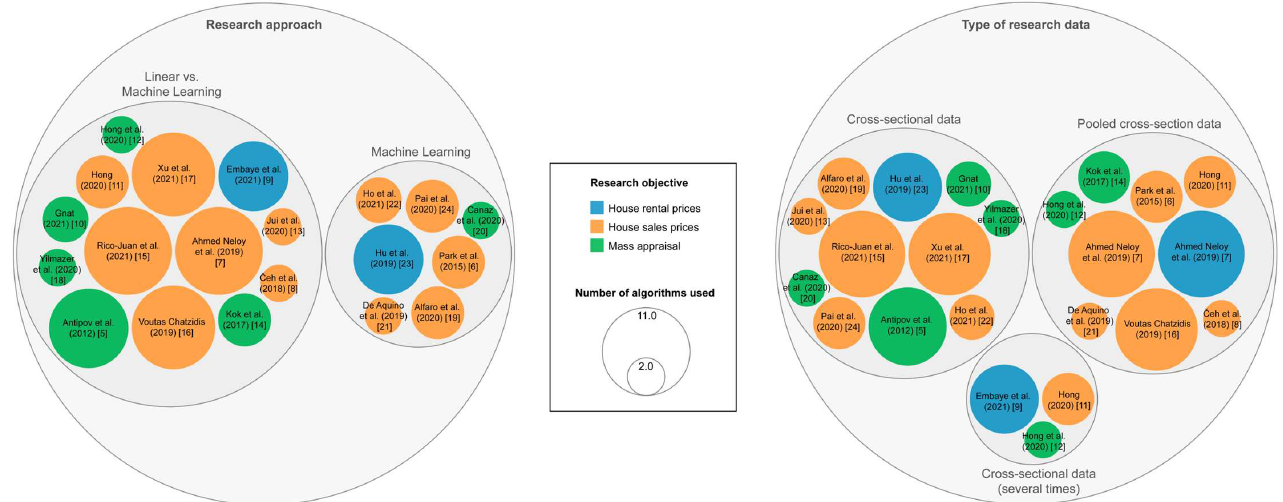
Figure 1. Classification of articles according to the research approach ( left ), and according to the type of research data ( right ). The legend ( center ) shows in color the research objective and the size of the circle shows the number of algorithms used by the authors. Source: own elaboration. Note: Studies used to create the figure: [5–24].